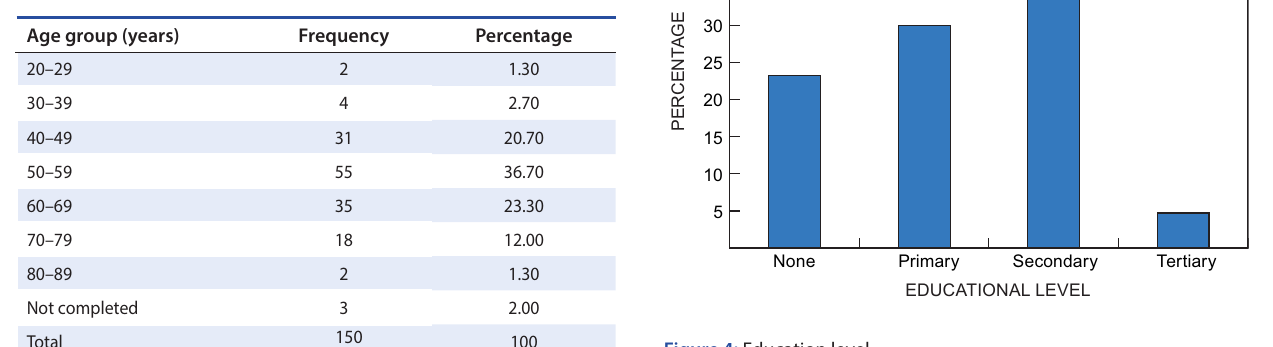
Figure 4: Education